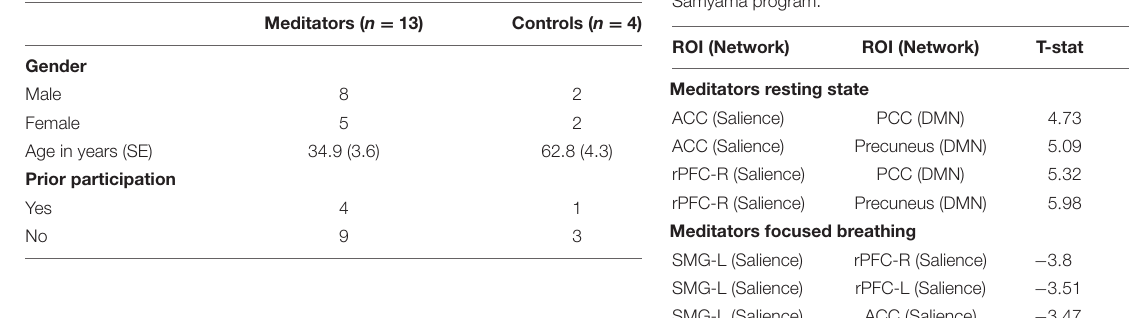
TABLE 1 | Demographic data of Samyama meditators and controls. TABLE 2 | Comparison in meditator functional connectivity from before and after